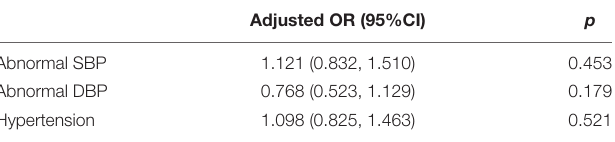
TABLE 4 | Multiplicative interaction between ODI and